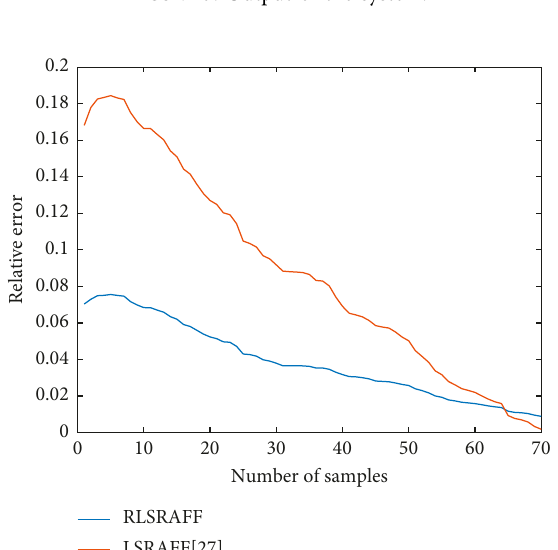
Figure 5: Output of the system.